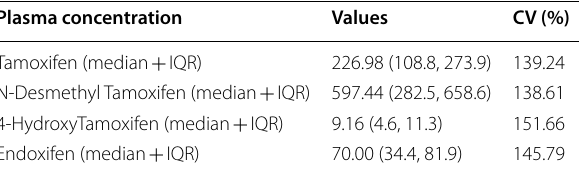
Table 5 Plasma concentrations of Tamoxifen and its metabolites